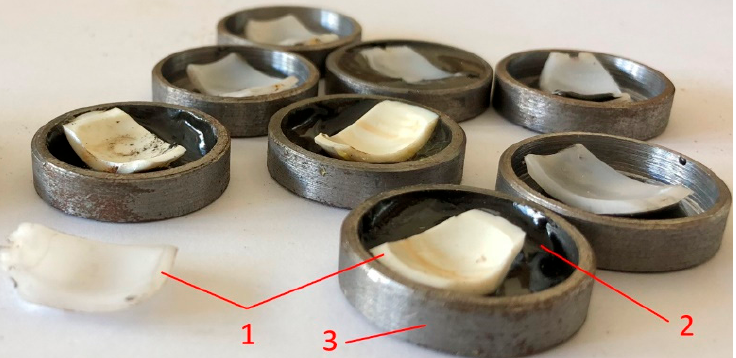
Figure 5. Prepared samples of POM and PEEK bearing of analyzed ball joints.